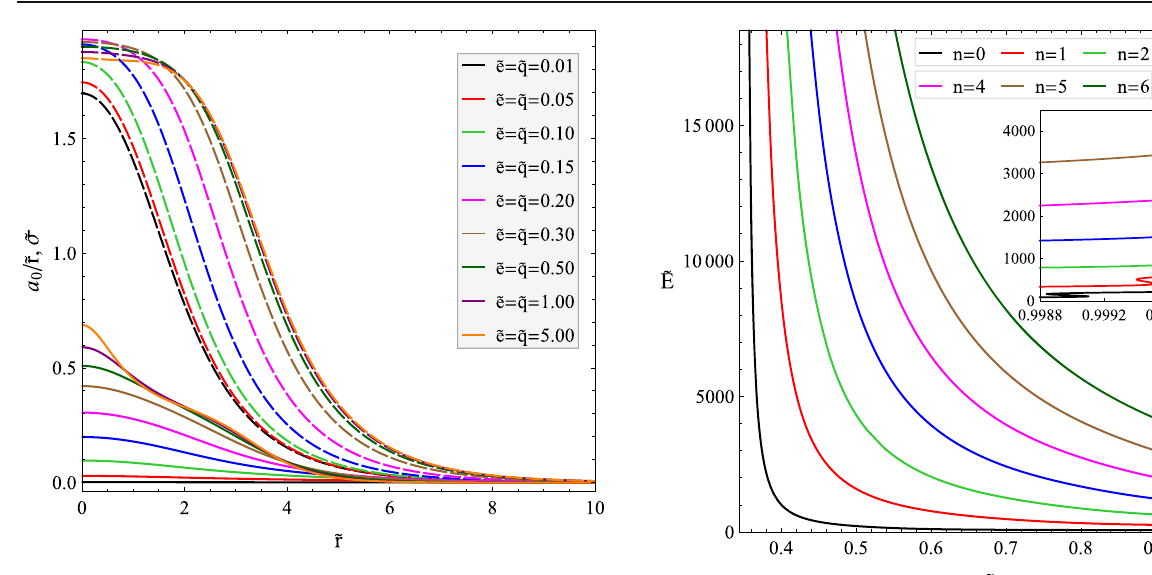
Fig. 5 Profile functions a 0 / ˜ r (solid curves) and ˜ σ (dashed curves) of the vortex-Q-ball system for different values of the gauge coupling constants. The curves correspond to parameters ˜ ω = 0 . 7, ˜ m = 1,